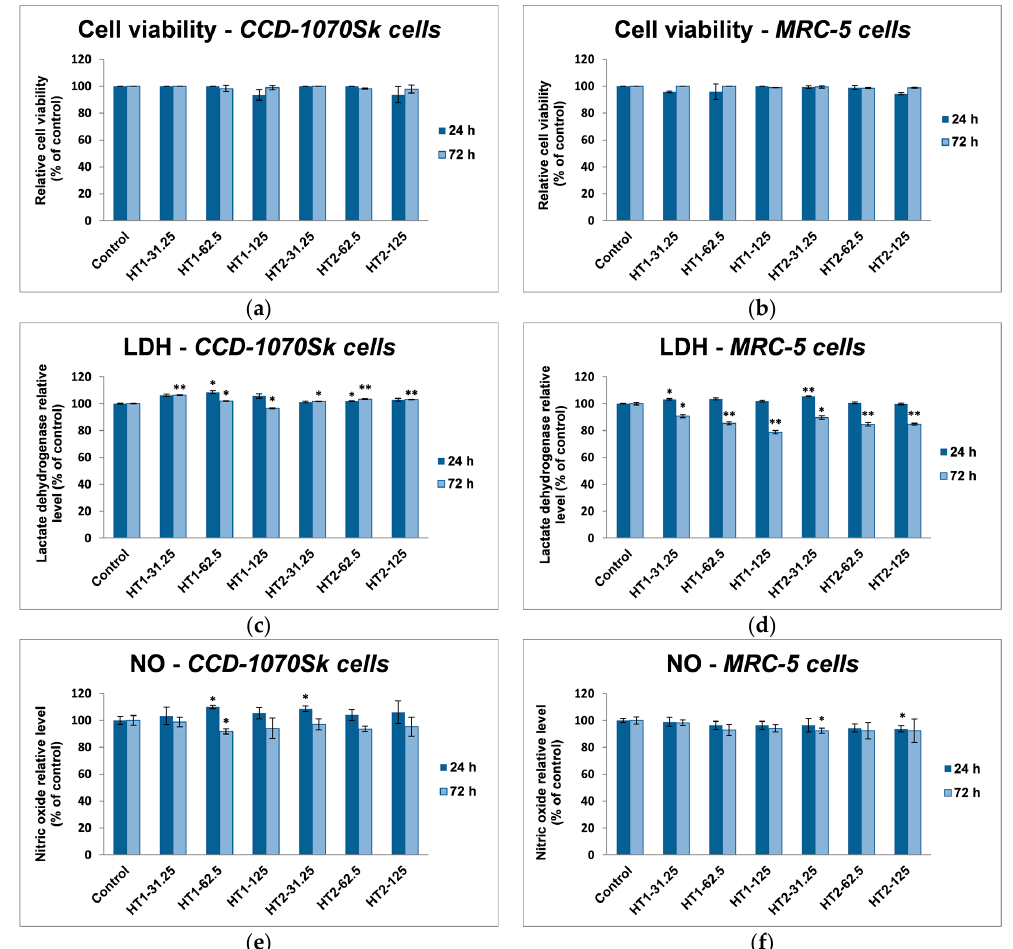
Figure 7. Biocompatibility of different concentrations ( μ g/mL) of the two TiO 2 NPs samples: TiO 2 -1% Fe–N NPs co-precipitated at pH 8.5 (HT1) or pH 5.5 (HT2), as shown by cell viability, lactate dehydrogenase (LDH), and nitric oxide (NO) release assays after 24 and 72 h exposure on normal skin ( a , c , e ) and lung ( b , d , f ) fibroblasts. Results are expressed as the mean ± standard deviation (SD) ( n = 3) and represented relative to the untreated cells (control). * p < 0.05 and ** p < 0.01 compared to control.